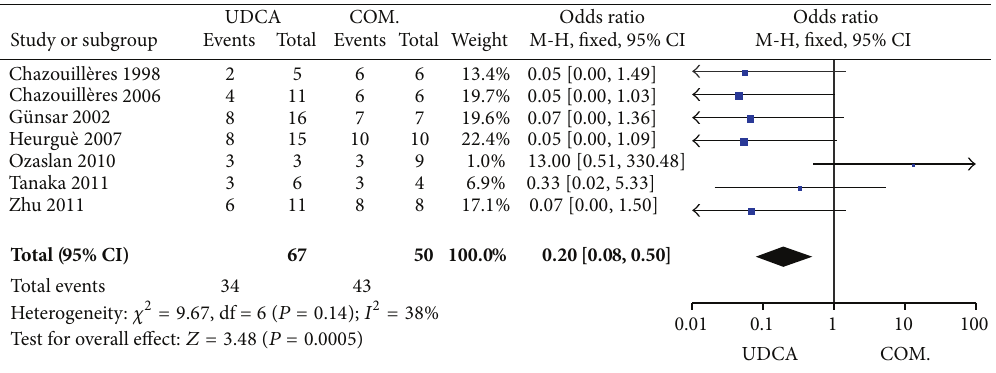
Total events Test for overall effect: Z = 3.48 ( P = 0.0005) Figure 3: Biochemical parameters of patients treated with monotherapy versus combination therapy for